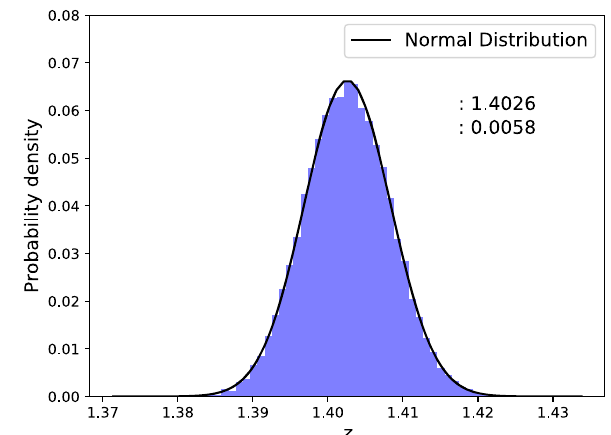
Fig. 5 Amplification factor g ( z ) of error propagation between Q and w . The blue line is g ( z ) , which is reconstructed via GP and MCMC from OHD (Table 1). The gray dashed horizontal line shows the value of zero. Note that, the g ( z ) reaches its minimum of zero at the D-B point and remains relatively small nearby. It means tighter constraints of the interaction can be made nearby the D-B point